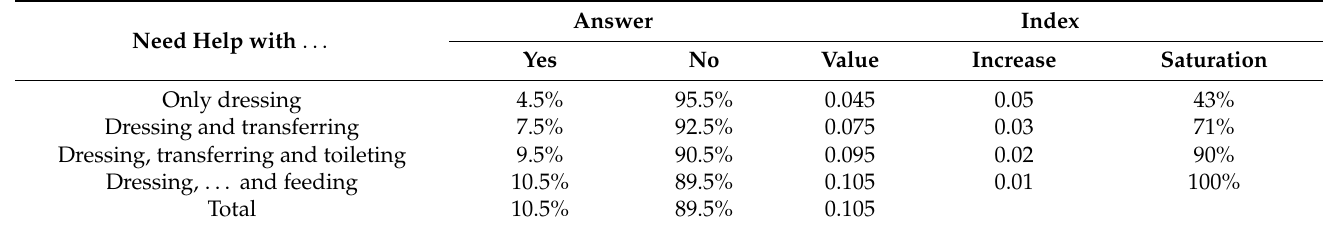
Table 6. Saturation analysis